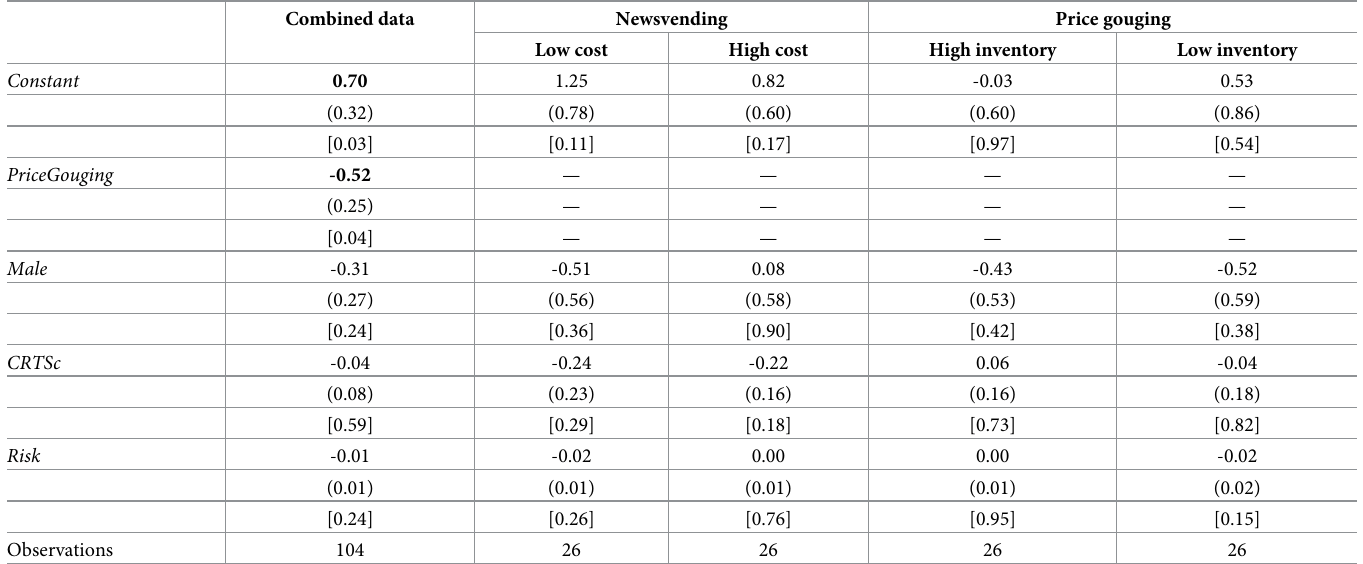
Table 7. Probit analysis of chasing